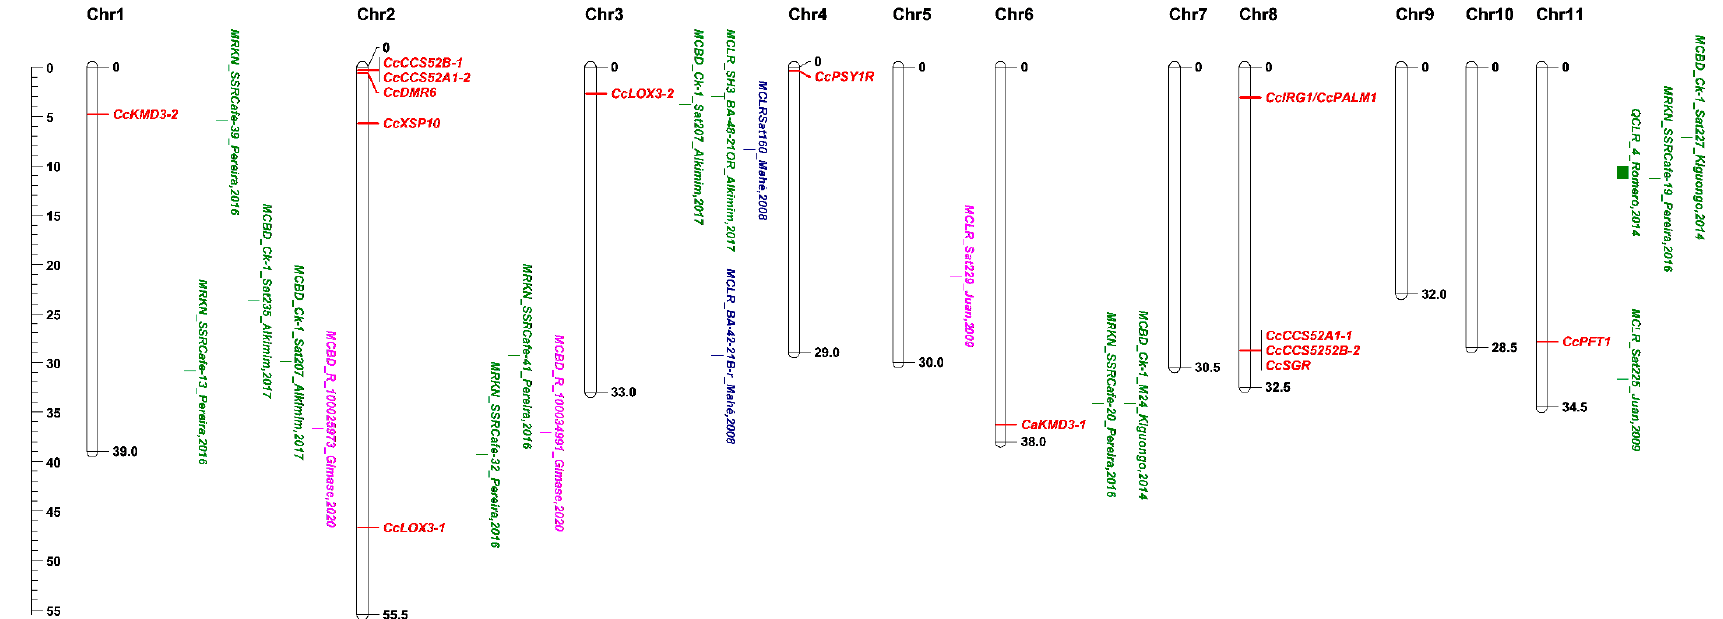
Figure 1. Physical positions at the Megabase (Mb) scale of previously described resistant genes, quantitative trait loci (QTLs), resistance-linked molecular markers, and putative susceptibility genes to coffee berry disease, coffee wilt disease, coffee leaf rust, and root-knot nematodes on the chromosomes of Coffea canephora according to the C. canephora genome database, The Coffee Genome Hub. QTL for resistance are displayed as bars and the names given by the authors are maintained [44]. Molecular markers are depicted as associated disease and original names given by the authors [41,43,45–49]. MCBD, MCLR, and MRKN denote molecular markers (M) associated with resistance to coffee berry disease, coffee leaf rust, and root-knot nematodes. Susceptibility candidate genes are indicated as red solid lines. QTL and markers derived from C. canephora are shown in green. The blue highlights indicate that the resistances are from C. liberica . Resistances originating from C. arabica are designated in pink color.